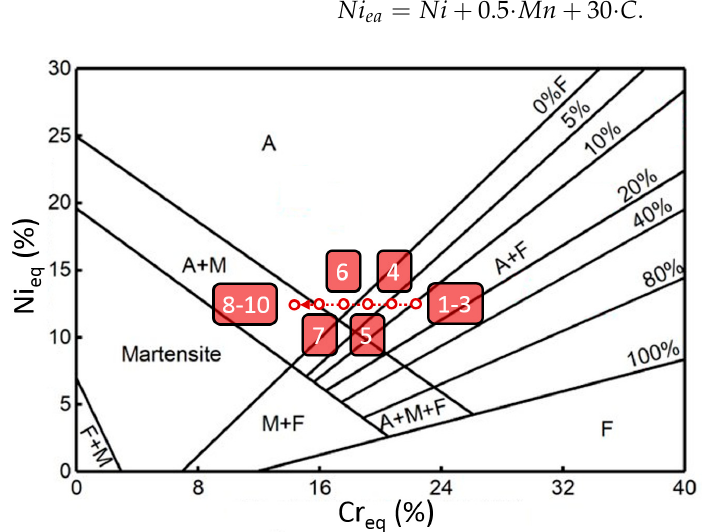
Figure 7. Schaeffler diagram for microstructural constituent estimation [36].